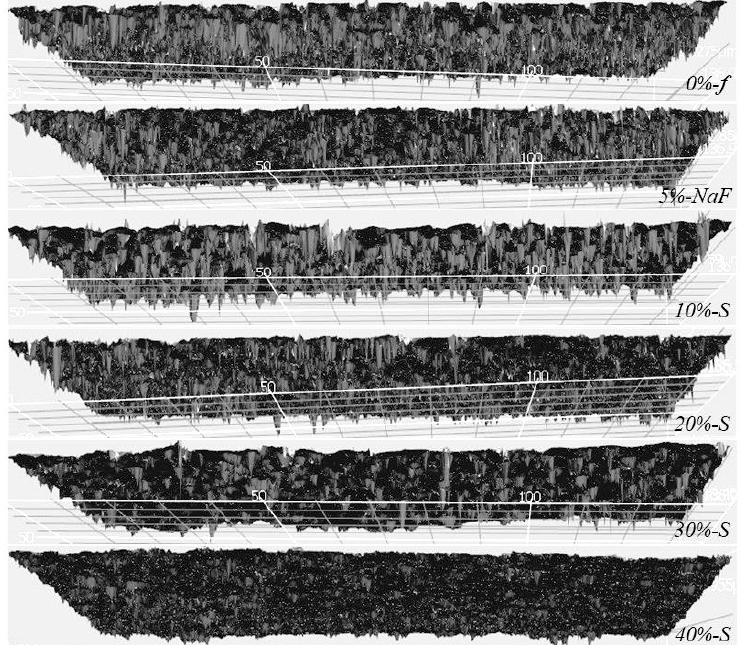
Figure 2. Confocal laser penetration (mountains and valleys/spikes) image of root dentin after 7 ‐ day biofilm attack. For control groups, the SzJIS is higher compared to the experimental group, showing more material occluded dentinal tubules and less laser penetration. The mean surface roughness (SzJIS; μ m) of ten representative DTs for each specimen using the MultiFileAnalyzer program supplied the CLSM, a two ‐ point analysis method. It shows SzJIS values (the average distance between five highest peaks and five lowest valleys).